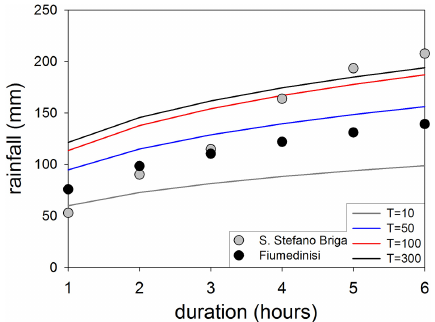
Figure 2. Regional depth-duration-frequency relationship for the study area for return periods ranging from 10 to 300yr. Observed maxima for rainfall durations ranging from 1 to 6h measured at the rain gauge stations of S. Stefano and Fiumedinisi during the 2009 event are also